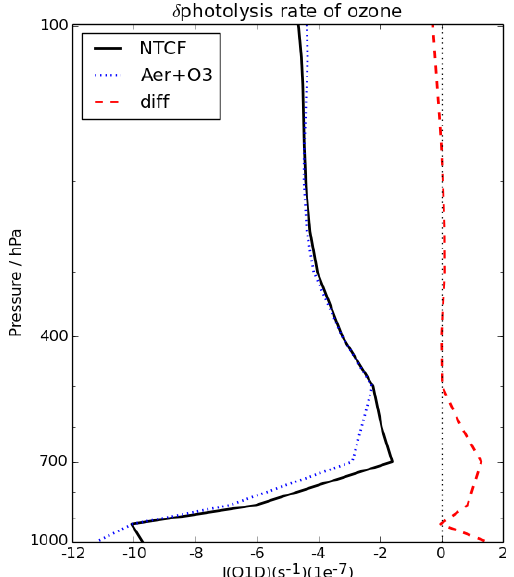
Figure 13. Vertical distribution of changes in j (O 1 D ) photolysis rates (10 − 7 s − 1 ) in piClim-NTCF (black solid line), the sum (blue dotted line) of piClim-aer and piClim-O3 relative to piClim-control , and the difference between them (red dashed